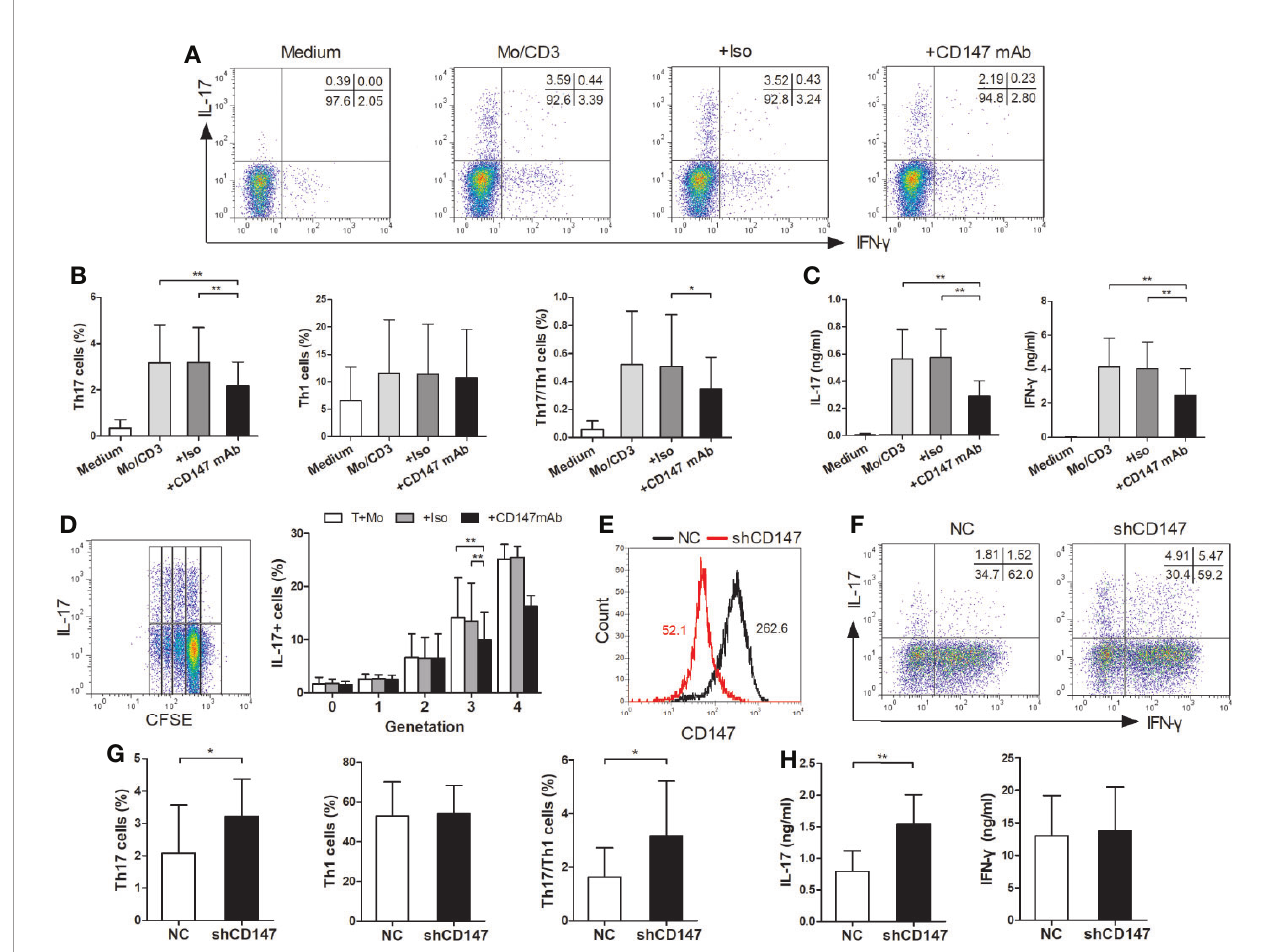
FIGURE 2 | CD147 suppresses human Th17 responses. (A – C) CD4 + memory (Tm) cells from HC were cocultured with medium or LPS-activated monocytes (Mo) and anti-CD3 mAb, in absence or presence of isotype control mAb (Iso) or Anti-CD147 mAb for 3 days. Representative plots (A) and quantitative results of Th17, Th1 and Th17/Th1 cell percentages (B) in T cells, and IL-17 and IFN- g production in cell culture supernatants (C) are shown (n = 9). (D) CFSE-labeled CD4 + Tm cells were cocultured with LPS-activated Mo and anti-CD3 mAb in presence of Iso or anti-CD147 mAb for 3 days and then assessed the percentage of IL-17 producing cells in each generation (generation 0 – 3, n = 10; generation 4, n = 4). (E) Representative CD147 staining histogram in CD4 + Tm cells from HC transduced with lentivirus expressing negative control shRNA (NC) or shRNA for CD147 (shCD147). (F-H) NC and shCD147 transduced CD4 + Tm cells were cocultured with autologous LPS-activated Mo. Representative plots (F) and quantitative results of intracellular expression of IL-17 and/or IFN- g (G) in T cells, and IL-17 and IFN- g levels in cell culture supernatants (H) were shown (n = 9). * P < 0.05; ** P <